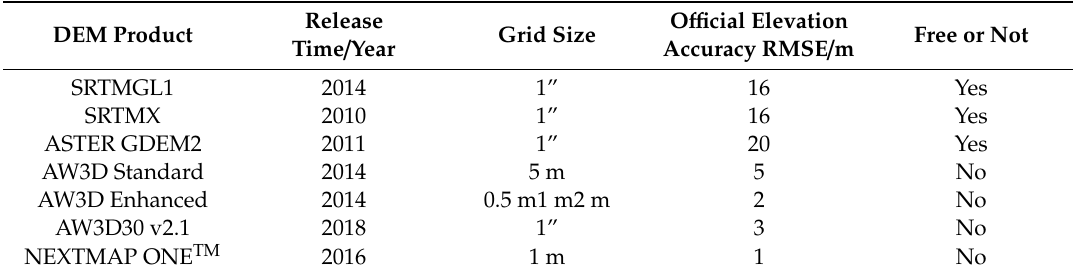
Table 5. High resolution global DEMs